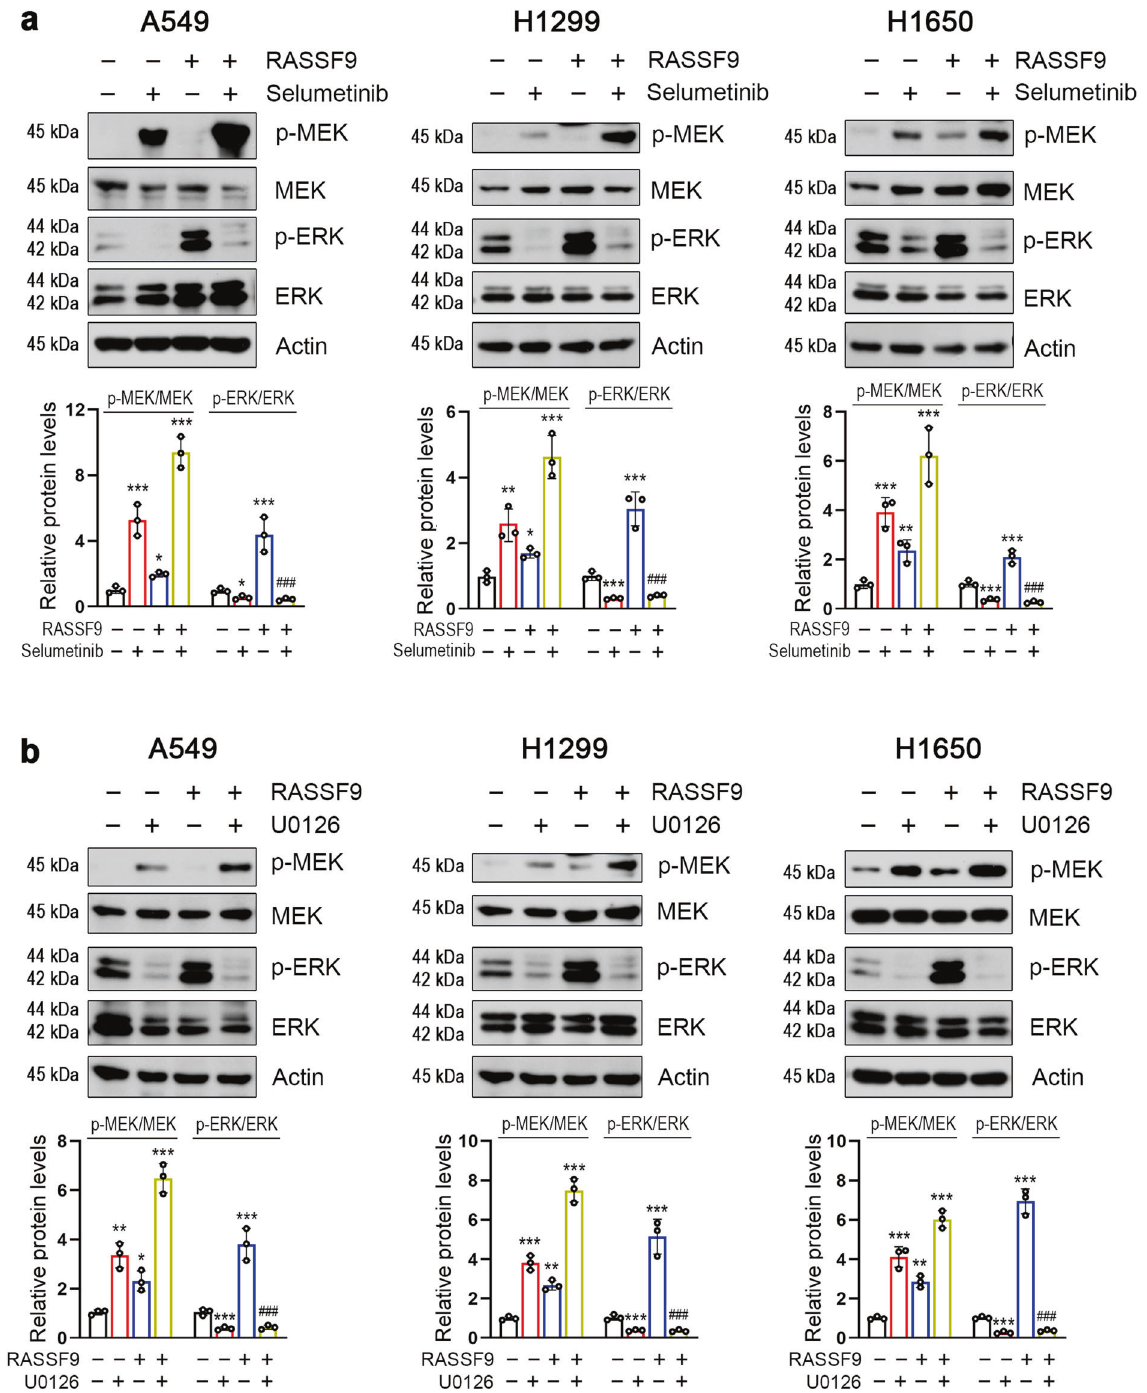
Fig. 7 MEK inhibitors neutralize RASSF9-induced ERK activation. a Inhibition of MEK using selumetinib abolishes RASSF9-induced ERK activation. b Inhibition of MEK by U0126 reduces RASSF9-induced ERK activation. A549, H1299, and H1650 cells were transfected with the plasmid expressing Rassf9 . Twelve hours post-transfection, cells were treated with 10 μ M of U0126 or 10 μ M of selumetinib for additional 24 h. Total cell lysates were prepared and subjected to western blot analysis. Actin was used as a loading control. Data are presented as means ± SD (error bars). * P < 0.05, ** P < 0.01, and *** P < 0.001 versus the control cells. ### P < 0.001 versus the cells transfected with the plasmid expressing Rassf9 . One-way ANOVA